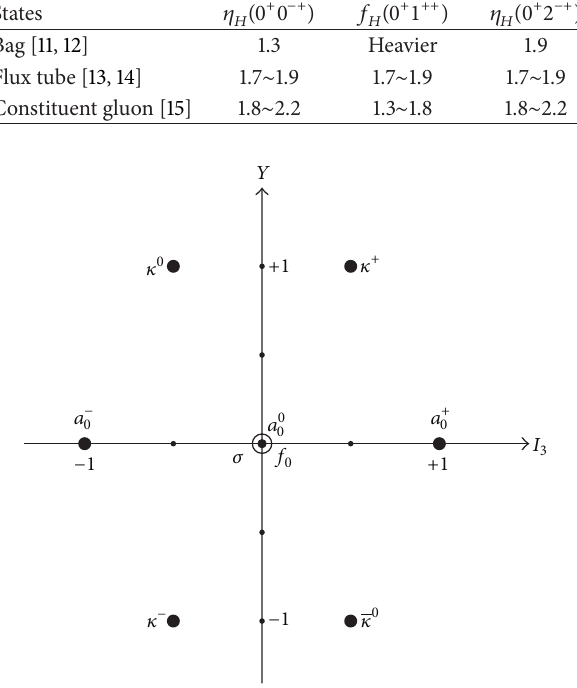
Figure 2: The “ S ” nonet below 1GeV shown in 𝑌 - 𝐼 3